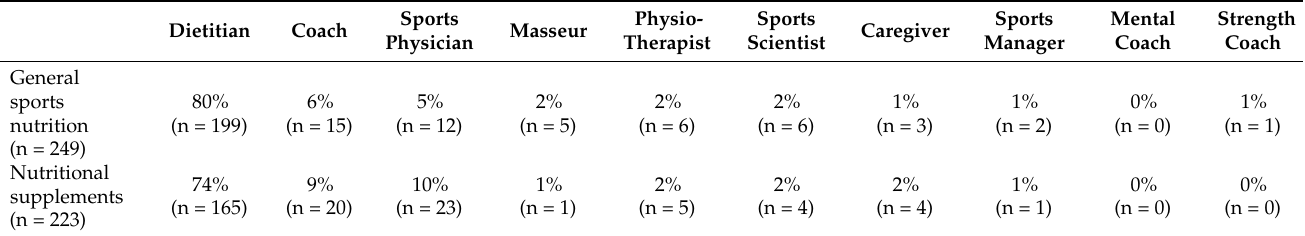
Table 4. Participating sports health professionals identified the profession with the ultimate expertise on sports nutrition and supplements.